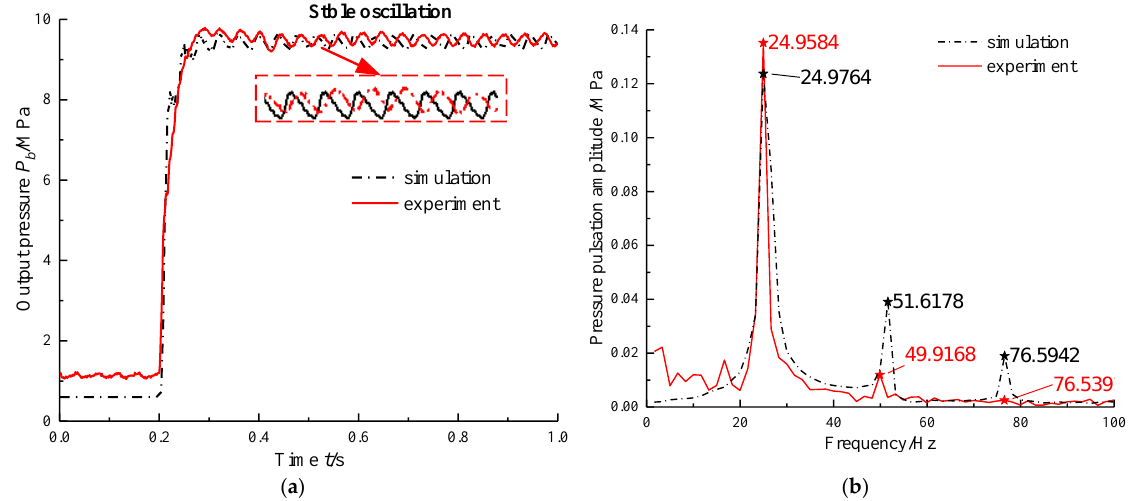
Figure 8. Experimental results of output pressure under step signal: ( a ) Time domain curve, ( b ) FFT spectrum of output pressure.